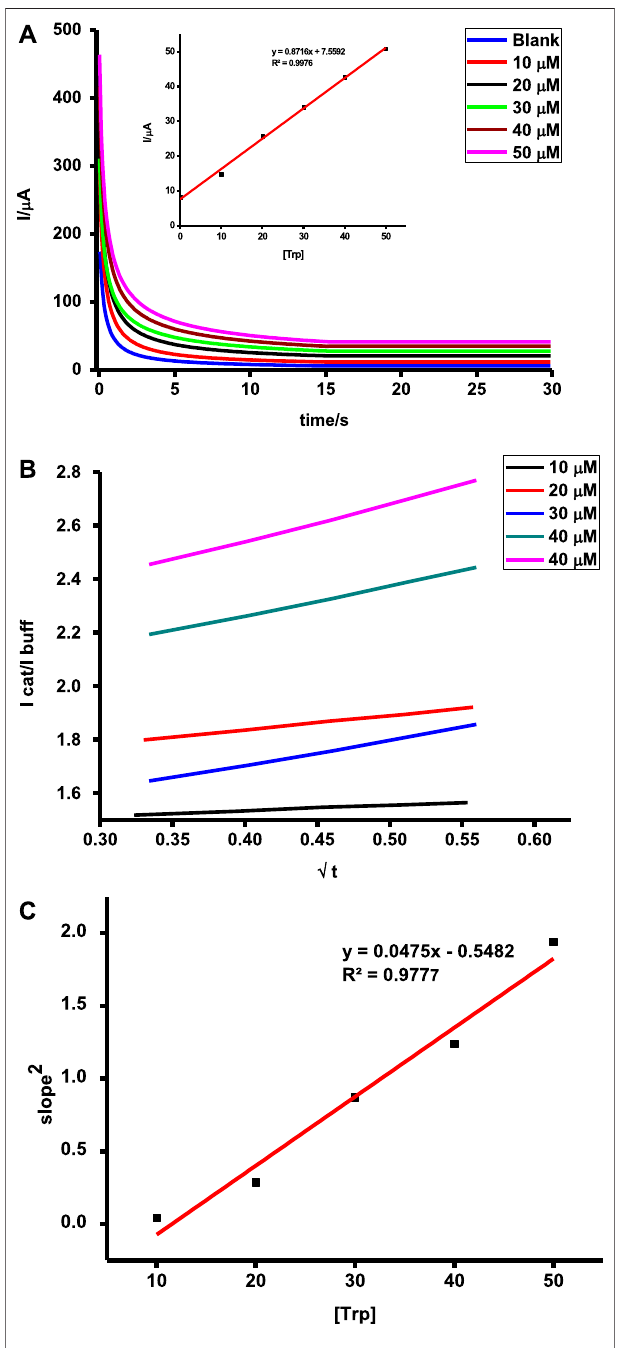
FIGURE 10 | (A) Chronoamperometric scans (inset = dependence of tryptophan concentration on current); (B) plot of I cat /I buf vs. t 1/2 ; (C) plot of concentration of tryptophan vs. square of slopes on (B) determined using chronoamperometry for the poly-CoTAPc-CoTAPc-GO/GCE electrode.